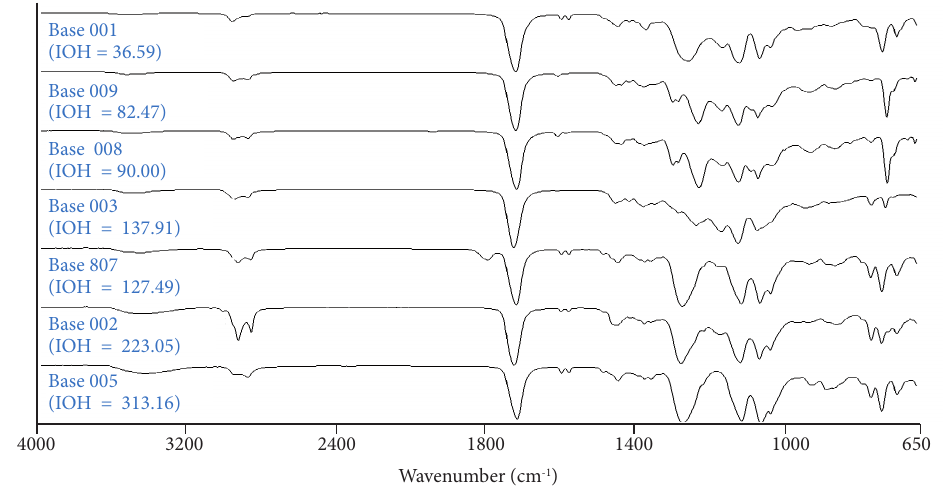
Figure 8. NIRA calibration curve for IOH determination in surfactants – A 7000 versus IOH (measured by wet chemistry method). IOH = Hydroxyl number; NIRA = Near infrared reflection analysis.